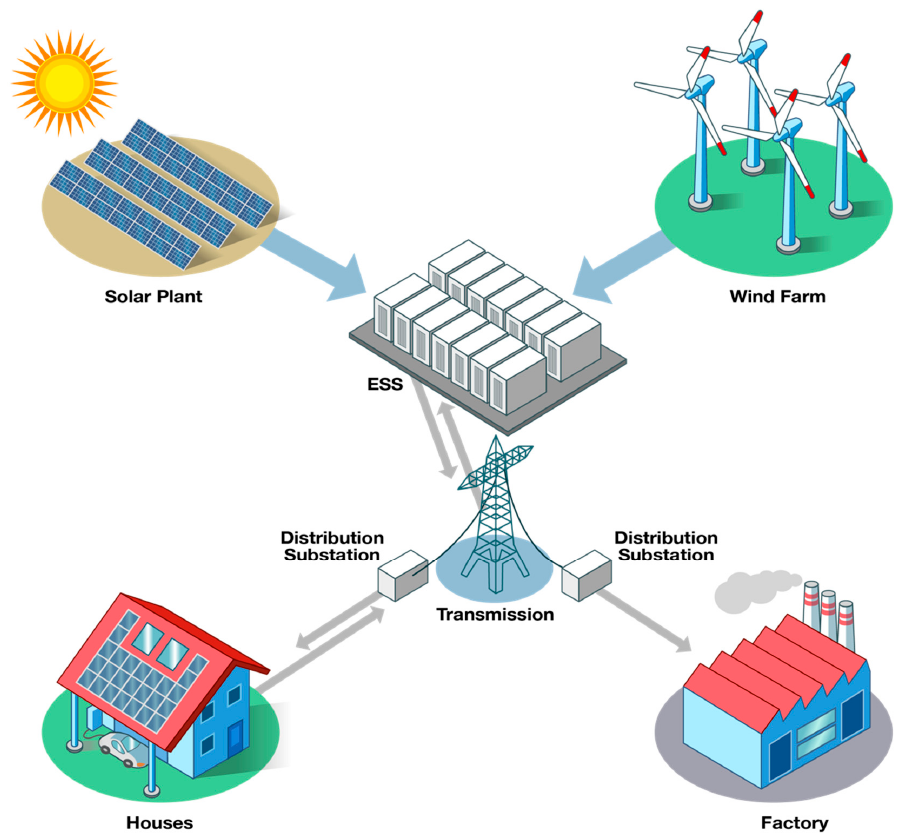
Figure 4. A power grid based on renewable energies.